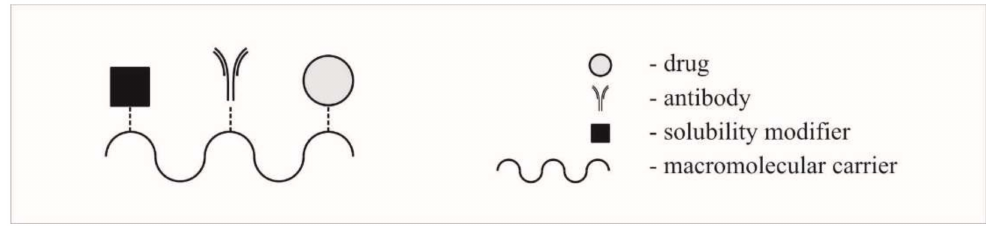
Figure 11. General model of